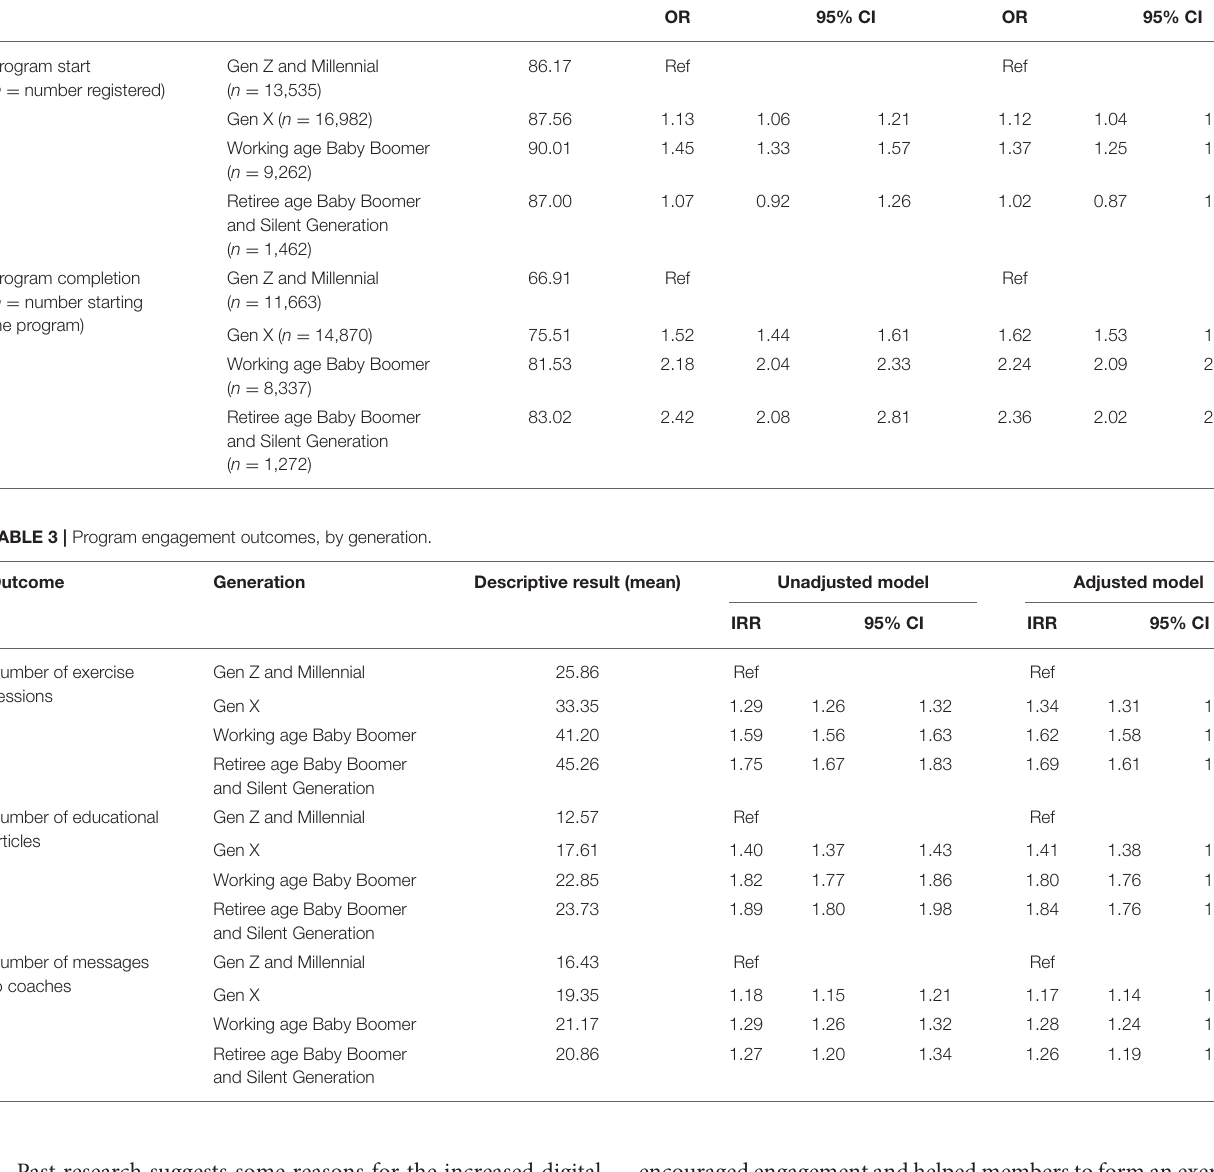
TABLE 2 | Program start and completion outcomes, by generation. Outcome